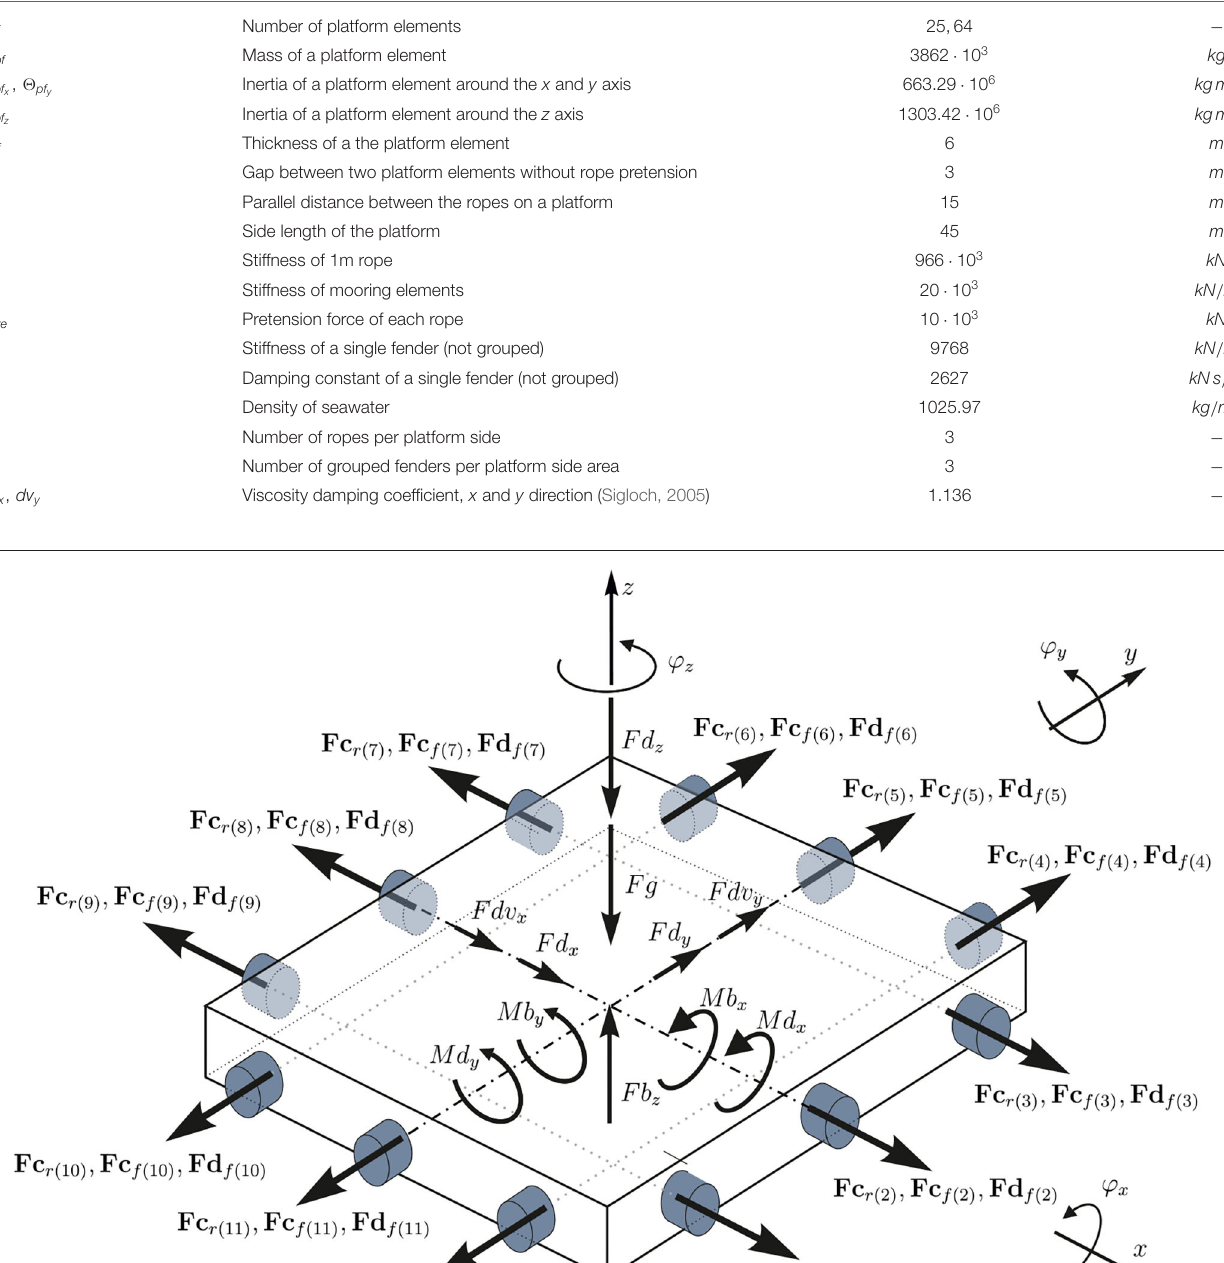
to zero. Also rope forces on this sides are not considered, hence rope forces inside the platform are internal force. At the corner platforms the mooring line forces are included. By applying